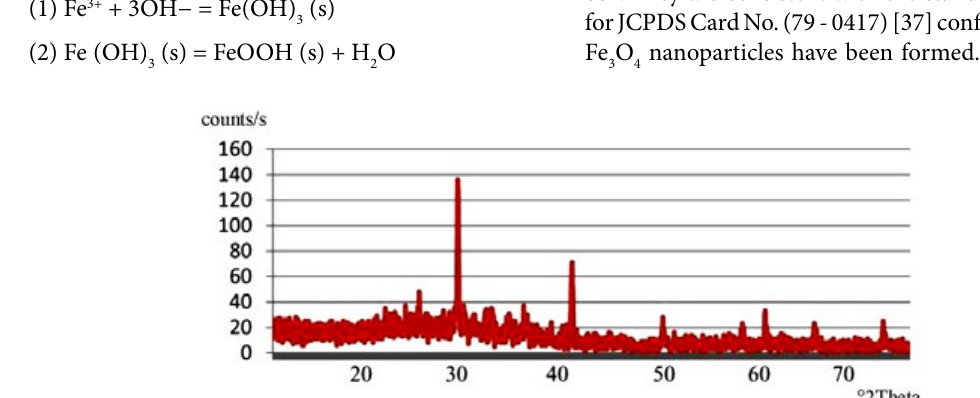
Fig. 2: XRD patterns of Fe Figure 2: XRD patterns of Fe 3 O 4 magnetic nanoparticles